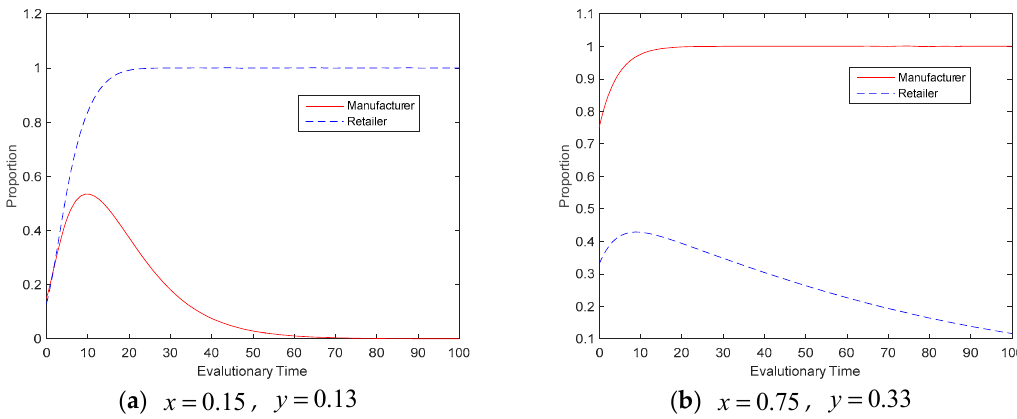
Figure 7. The Evolution Process of Evolutionary Stable Strategy of E 2 ( 1,0 ) or E 3 ( 0,1 )